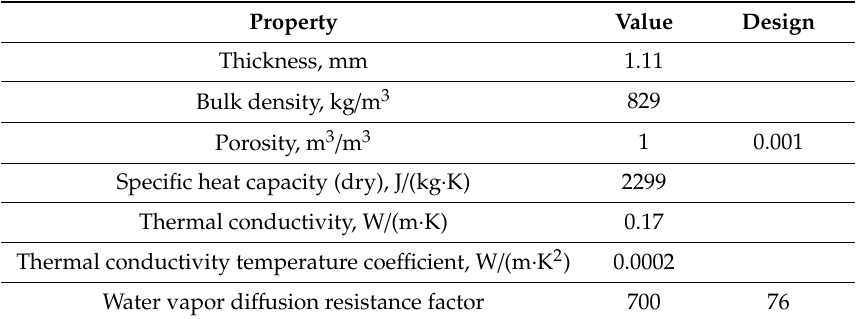
Table A1. Vinyl Siding property data—using e ff ective